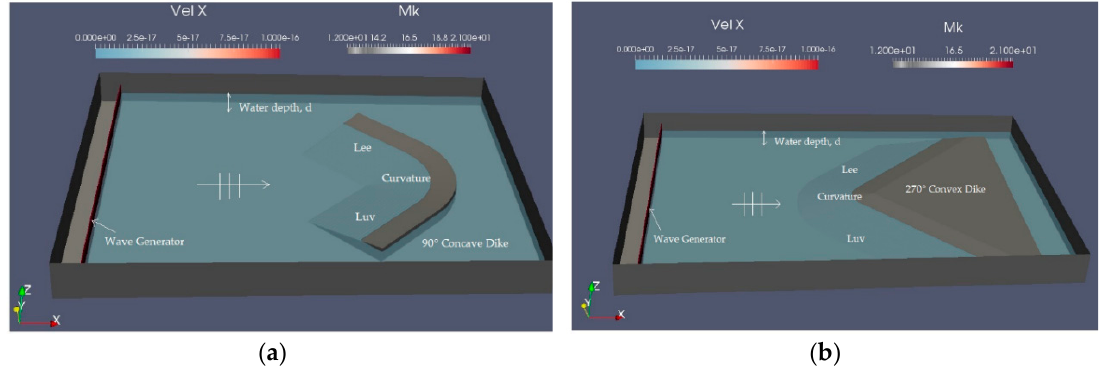
Figure 5. 3D numerical model of curved dikes in DualSPHysics: ( a ) 90° concave dike; ( b ) 270° convex dike.